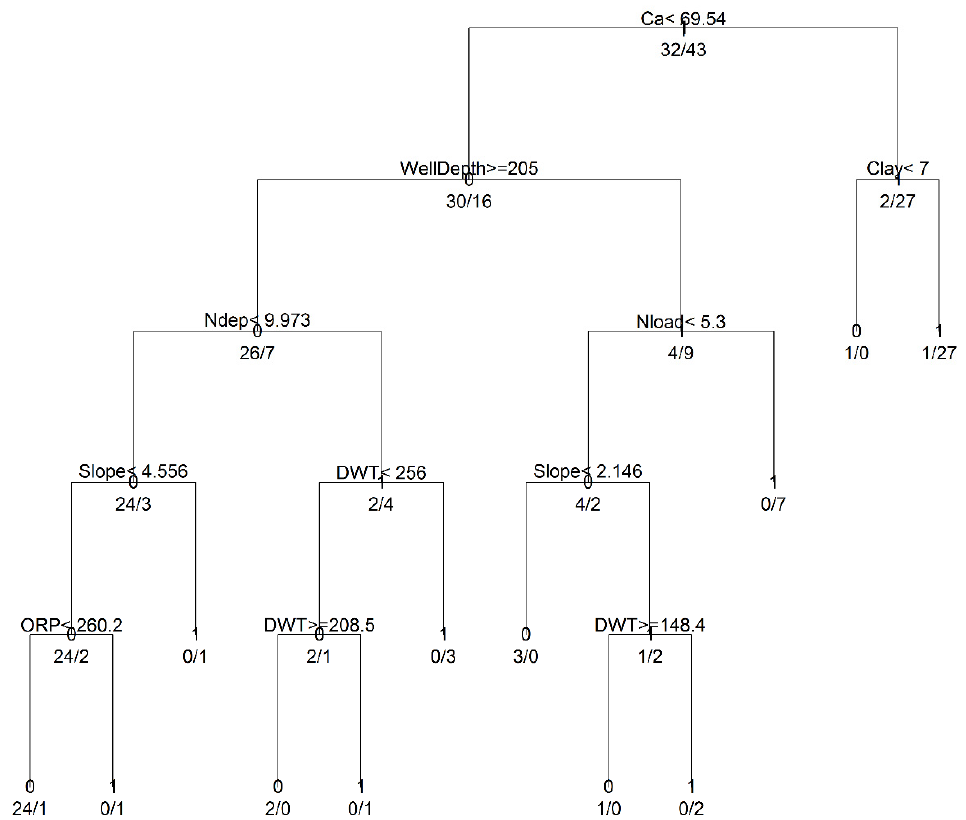
Figure 3. Classification and Regression Tree (CART) model for Nitrate Exceedances.